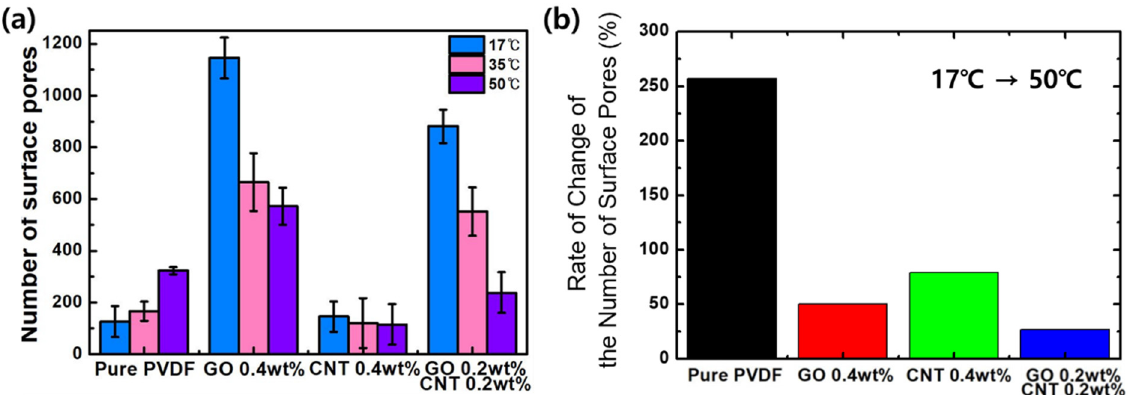
Figure 4. ( a ) The number of surface pores according to the content of carbon materials with changes in coagulation temperature. ( b ) Rate of change of the number of surface pores when the temperature increased from 17 to 50 ° C.